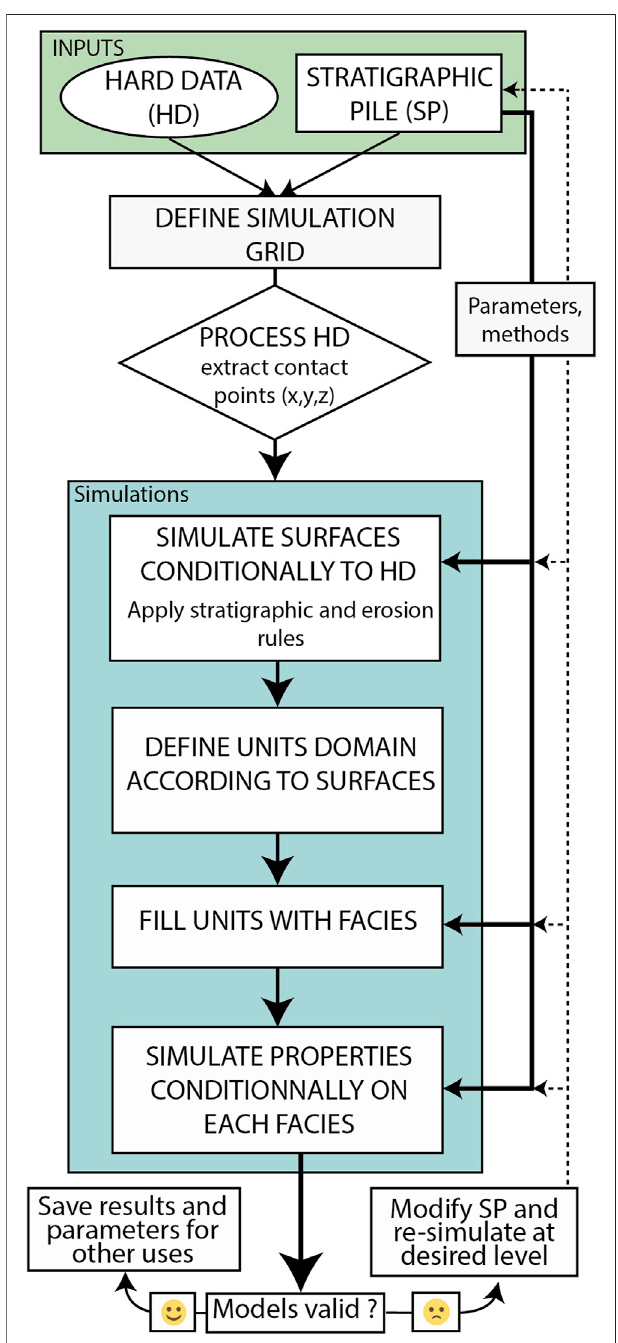
FIGURE 1 | Overview of the ArchPy